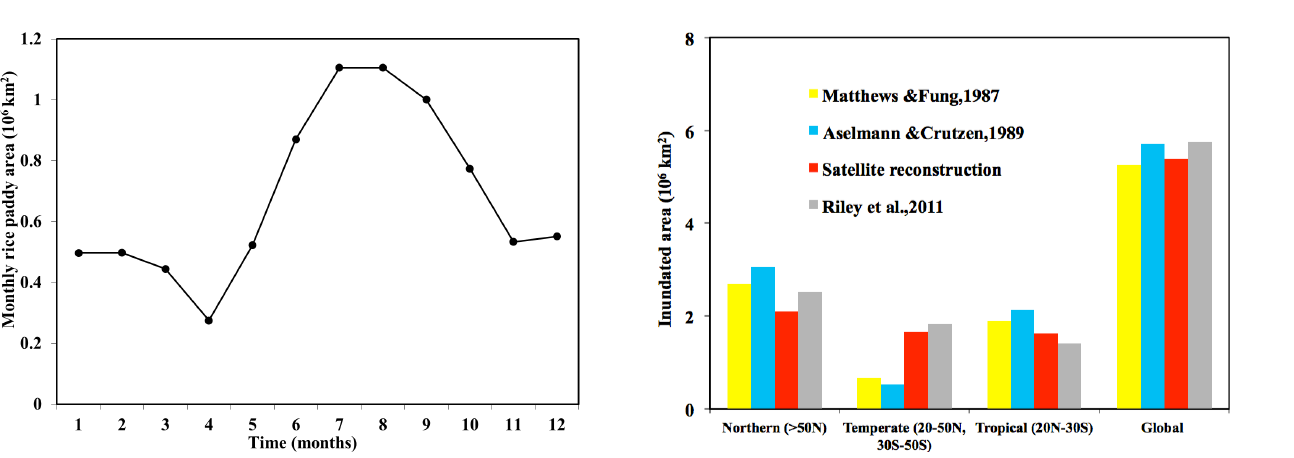
Fig. 4. Comparison of inundated areas used in different methane models with error bars indicating the range of annual mean inundated areas. For satellite reconstruction and Riley et al. (2011), we used the maximum monthly-inundated area during the period 1993-2000. Please note that rice paddy area was removed from the satellite reconstruction.